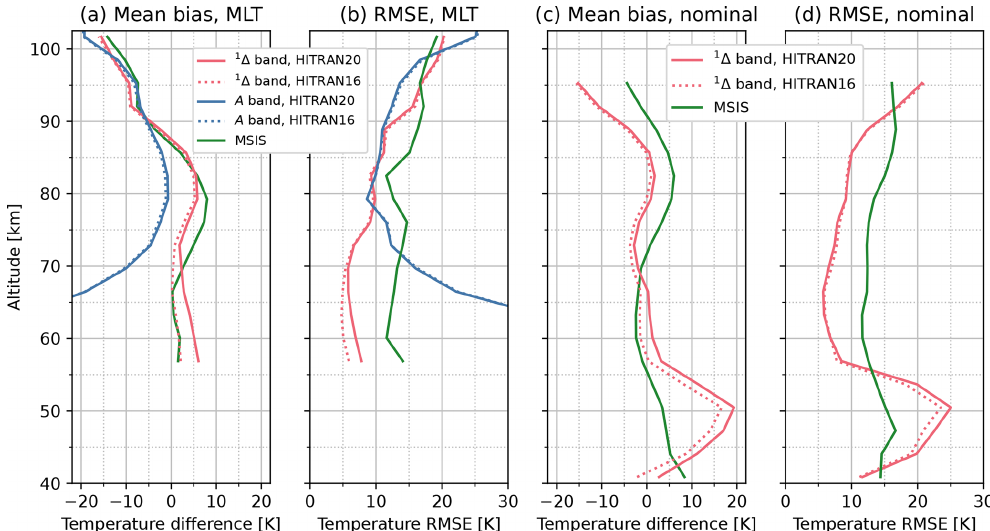
Figure 15. The mean bias (a) and RMSE (b) of 1 (cid:49) band (pink) and A band (blue) temperature retrieved from the MLT orbits relative to the colocated ACE-FTS profiles are shown. Panels (c) and (d) show similar statistics between the 1 (cid:49) -band temperature retrieved from nominal limb orbits and the colocated ACE-FTS profiles. Retrievals using HITRAN2016 spectroscopic data are shown as dotted lines, and retrievals using HITRAN2020 are shown as solid lines with the same